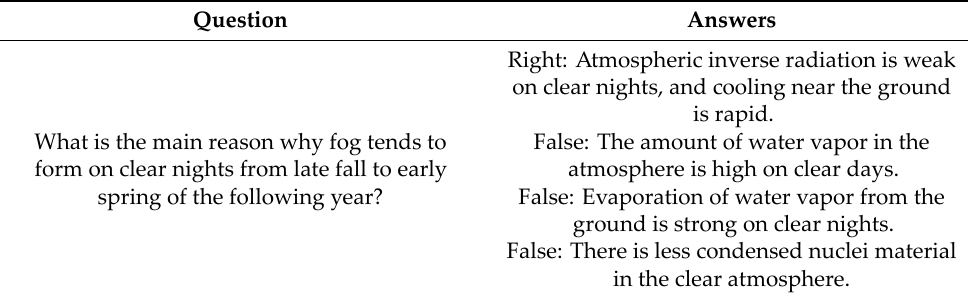
Table 1. Example of knowledge‑based QA.